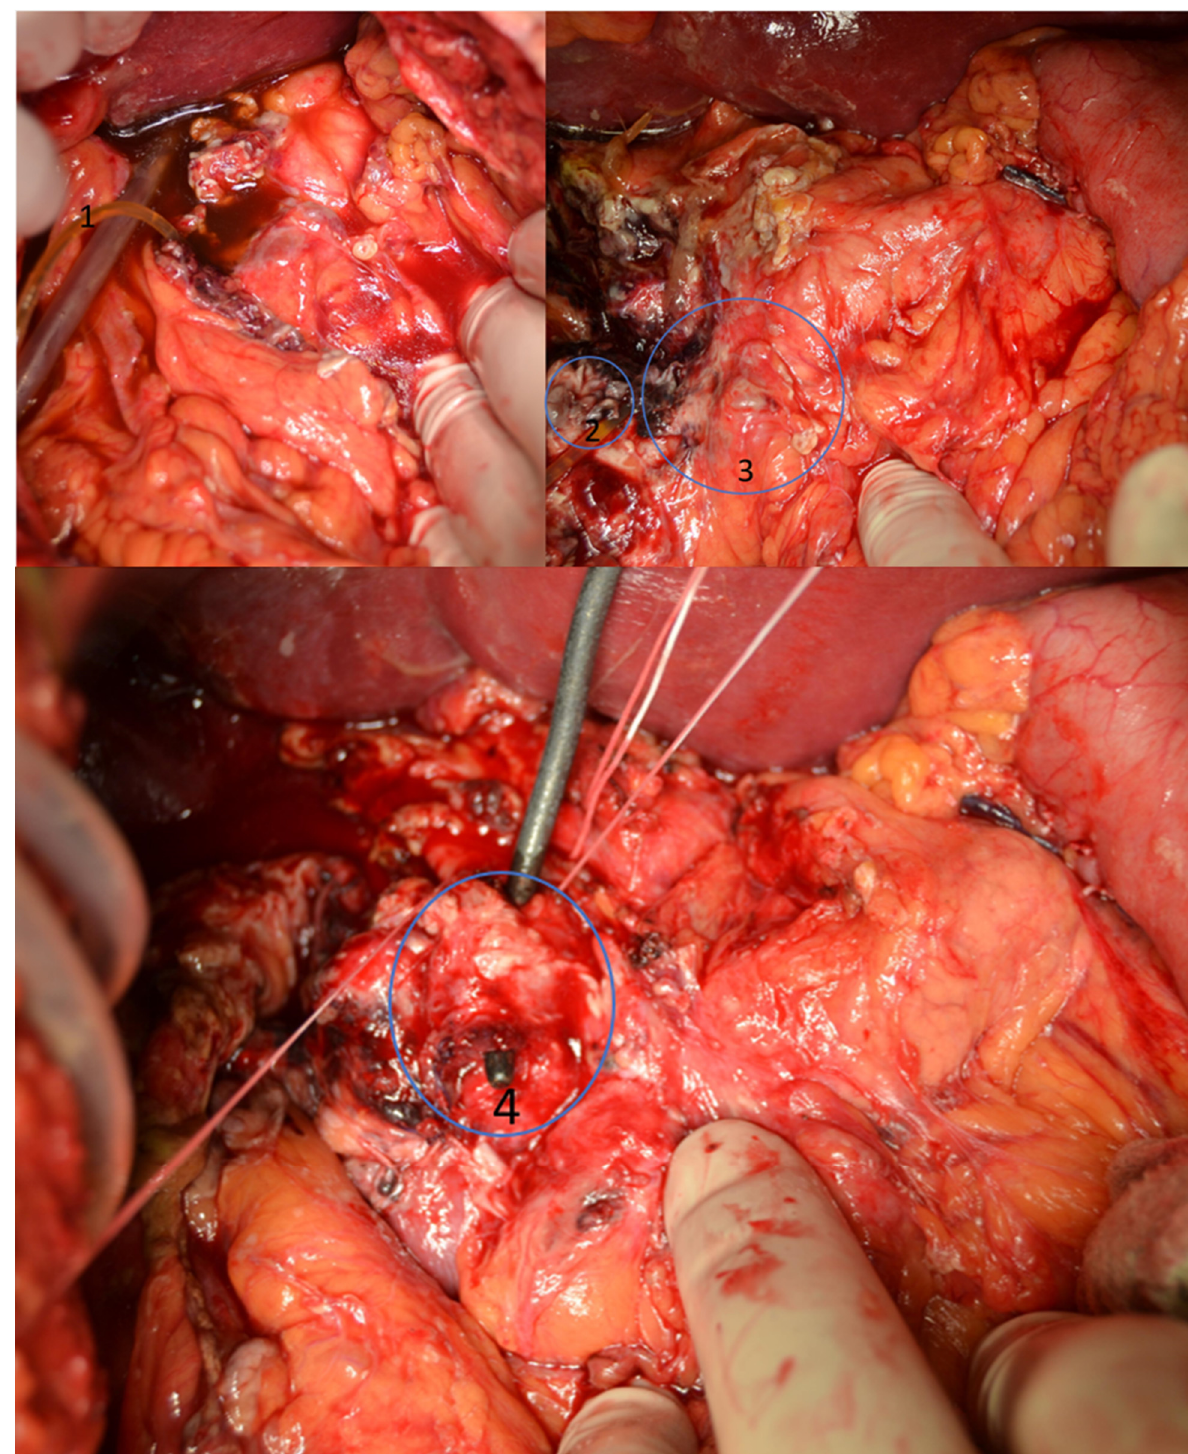
Figure 1. Intraoperative photo—the complex lesion of the duodenum, distal bile duct and pancreatic head. 1—Drainage tube placed in the bile collection, 2—Lesion of the duodenum, 3—Head of the pancreas, 4—Lesion of the distal common bile duct.